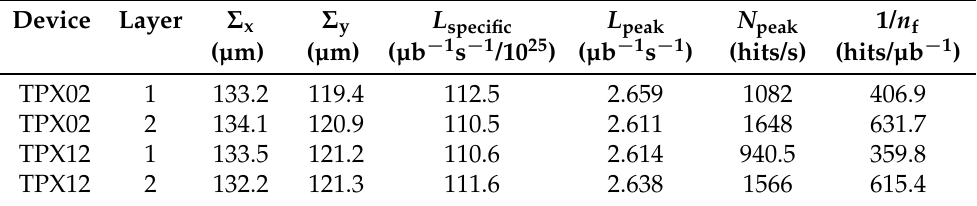
Table 23. vdM scan results for 2016 data. The scan was performed on 27 May (LHC fill 4954) and the first horizontal and vertical scans were used. The fit results for the first bunch-averaged horizontal Σ Σ x and vertical y convoluted beam sizes are given, as well as the specific luminosity. The peak luminosity takes the LHC operation parameters into account. The hit rate at the peak is averaged over the horizontal and vertical scans. Normalization factors (1/ n f ) convert hit rates to luminosities. The larger values are for the thicker sensor layer. Taken from Ref. [15].